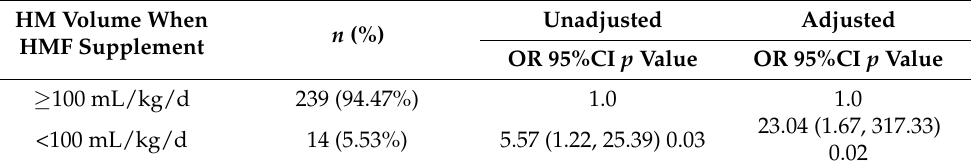
Table 4. Univariate and multivariate logistic regression to assess the association of HM volume when HMF supplement with FI. Dates, 2015–2018.